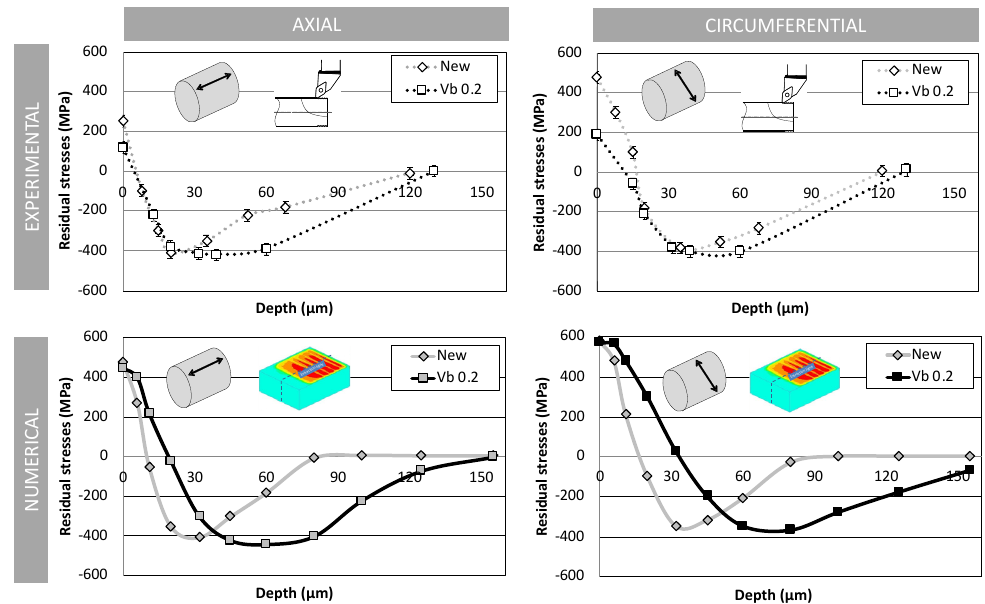
Figure 12. Effect of tool wear on residual stresses.